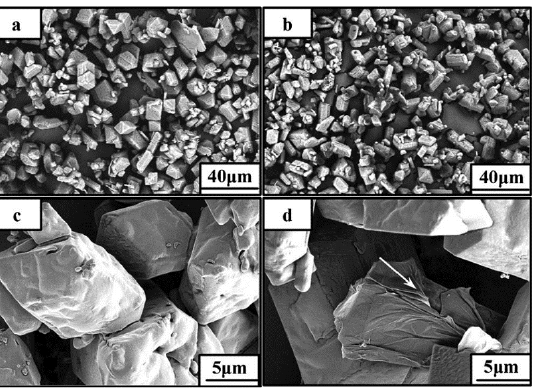
Figure 8. SEM images of HMX( a , c ) and HMX/graphene( b , d ). Figure 7. SEM images of HMX ( a , c ) and HMX/grapheme ( b , d ). Reprinted with permission from ref. [24]. Copyright 2013 John Wiley and Sons.